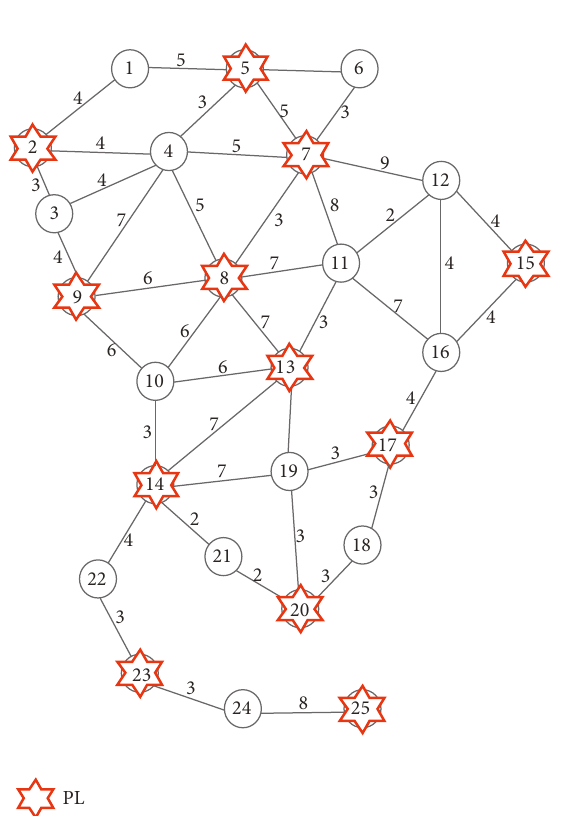
Figure 9: The 25-node transportation network.